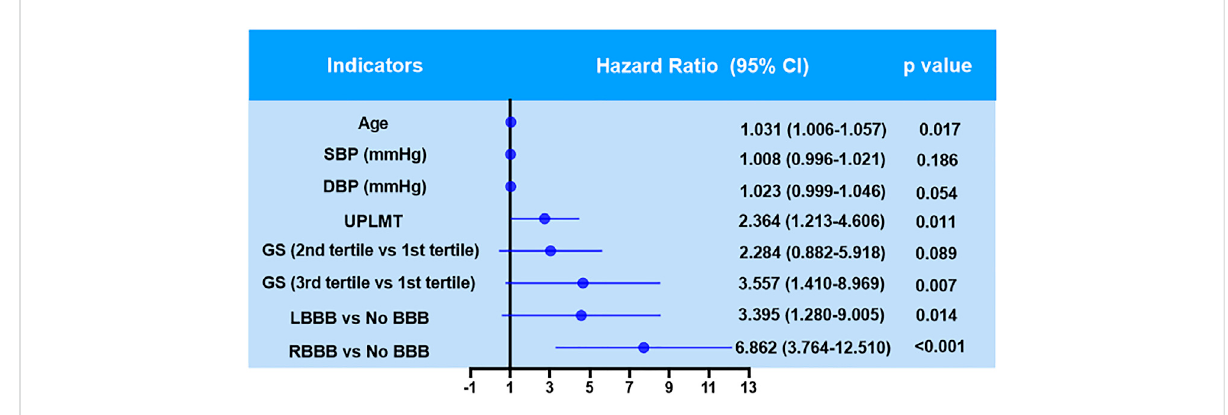
FIGURE 4 Hazard ratios for MACCEs in patients with new onset STEMI who underwent